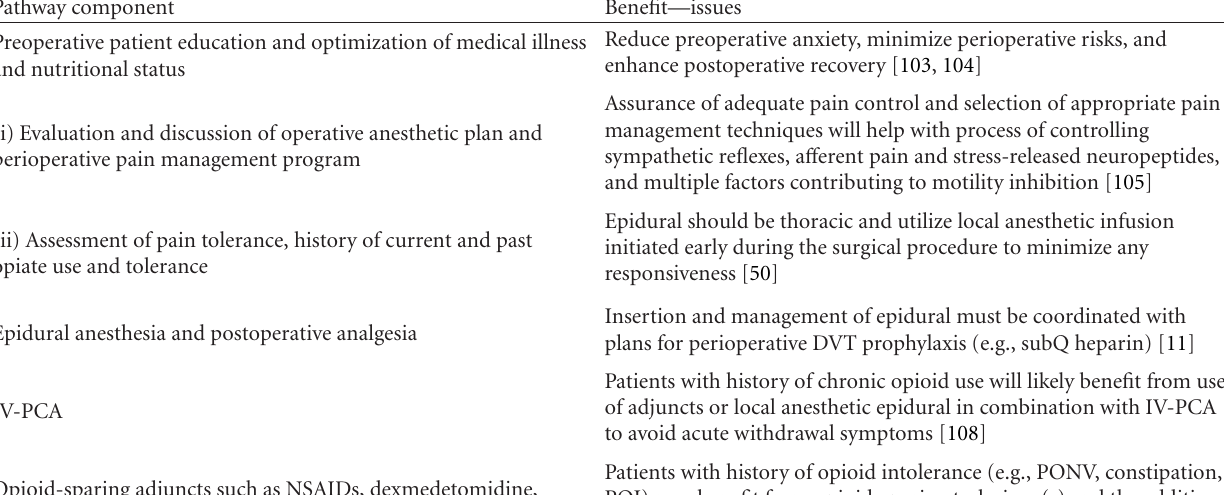
Table 1: Components of a multimodal management pathway for patients undergoing bowel